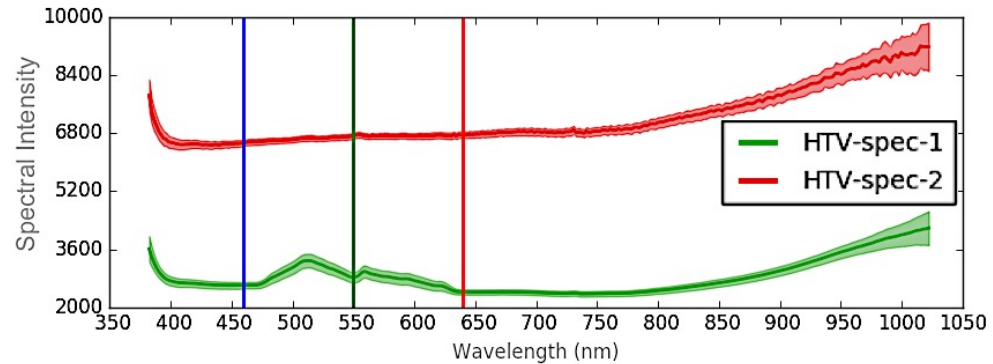
Figure 5. Wavelength plot for virgin (green) and aged (red) HTV.